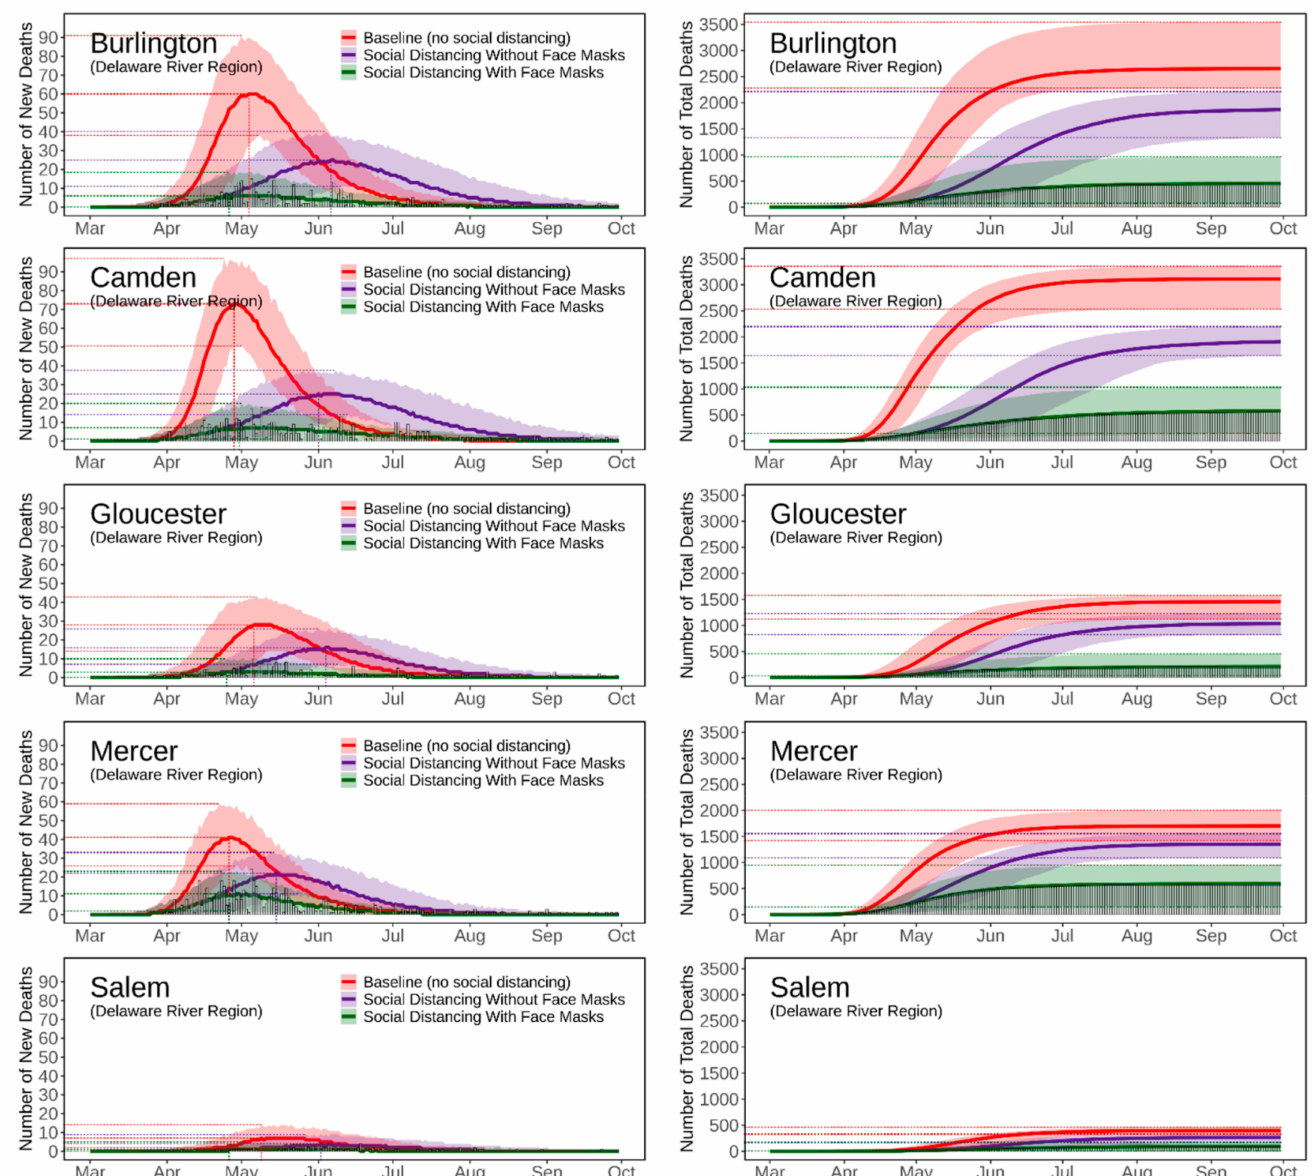
Figure 8. Predicted trajectories of new/total confirmed deaths from COVID-19 corresponding to three exposure scenarios for the counties in the Delaware River Region of NJ, March to September 2020, compared with reported death data (vertical bars). The color-shaded areas depict the 95% Confidence Interval (CI) of the corresponding